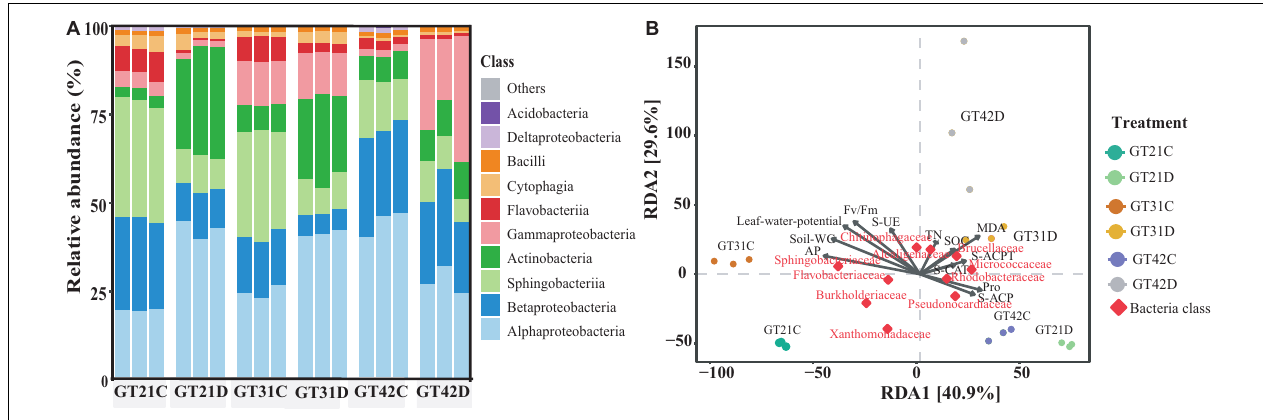
FIGURE 3 | The relative abundance of bacterial species in the rhizosphere bacterial community and the dbRDA redundancy analysis with environmental factors. (A) Relative abundance of dominant rhizosphere flora under different treatments, with three repetitions in each treatment (Top 10 in terms of OTUs). (B) Distance-based redundancy analysis between different varieties, water treatments, and environmental factors and dominant flora.